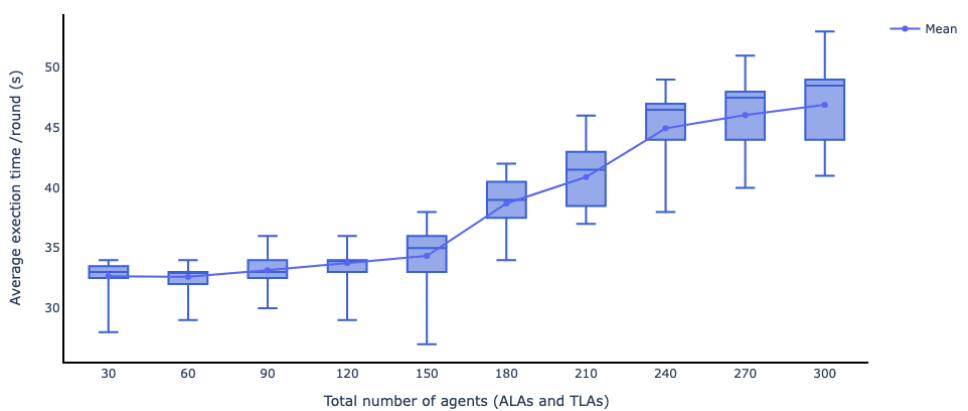
Figure 14. The scalability of the federated learning process using the FEDn